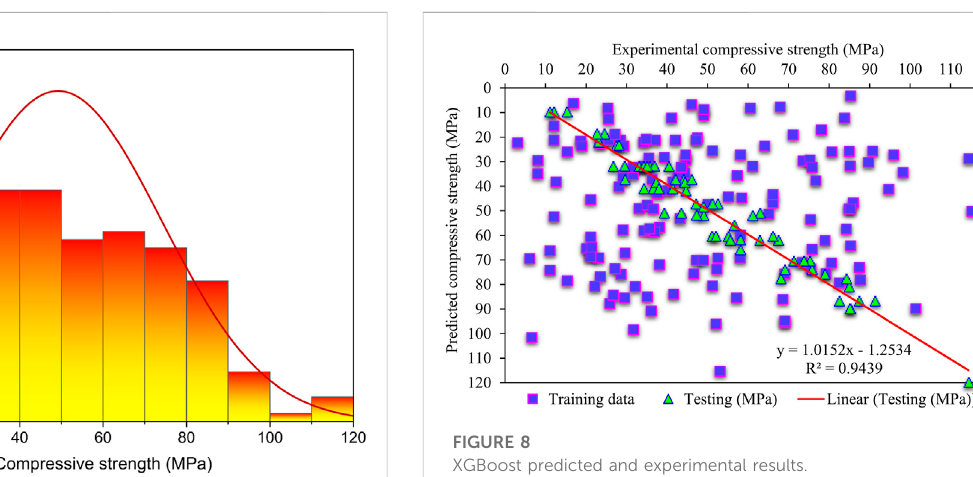
FIGURE 8 XGBoost predicted and experimental